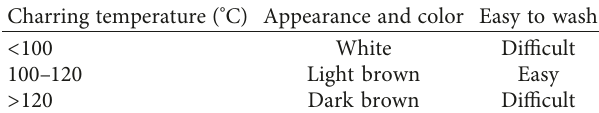
Table 2: Effect of carbonization temperature on product quality. Charring temperature ( ° C) Appearance and color Easy to wash